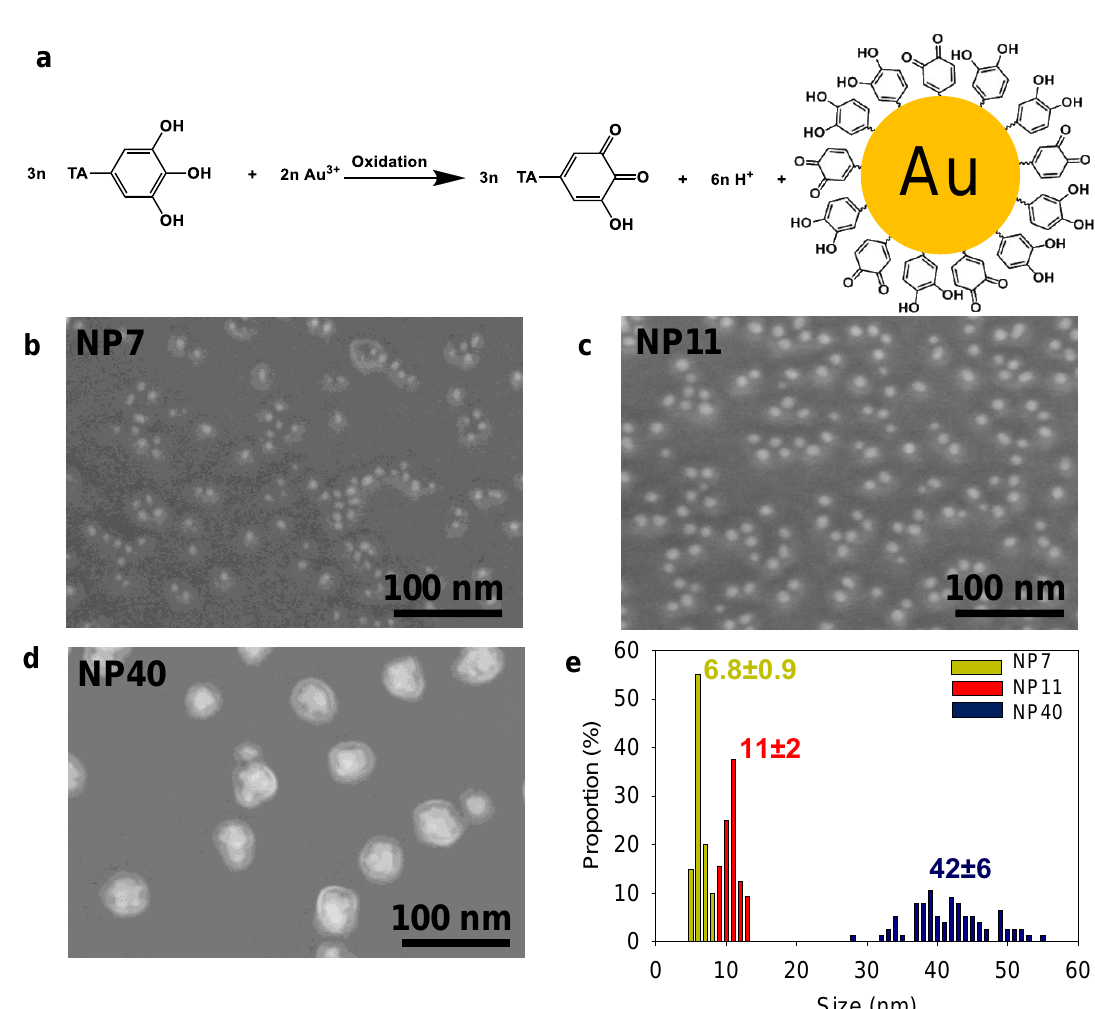
Figure 2. ( a ) Redox synthesis of tannic acid capped gold nanoparticles (NPs) based on TA and gold salt spontaneous reaction. SEM images of ( b ) NP7, ( c ) NP11, ( d ) NP40 and ( e ) their size (in nm) distribution retrieved from TEM size analysis.